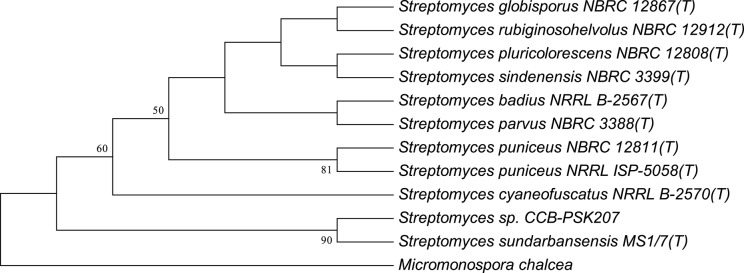
Tamura-Nei model of phylogenetic tree. Tree based on 16S rRNA gene sequences obtained by the Neighbor Joining (NJ) method showing the position of A5 isolate among its phylogenetic neighbors. Numbers at nodes indicate levels of bootstrap support (%) based on a NJ analysis of 1,000 resampled datasets.